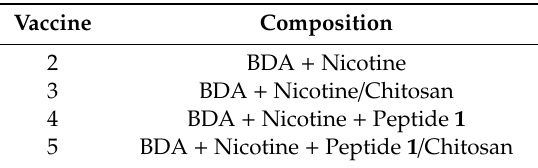
Table 3. Vaccine group